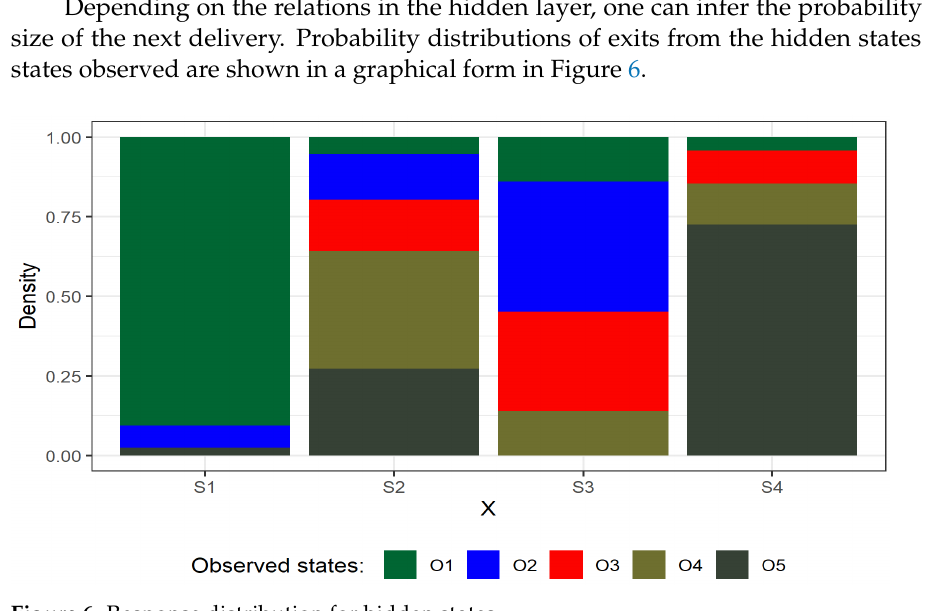
Figure 6. Response distribution for hidden states.